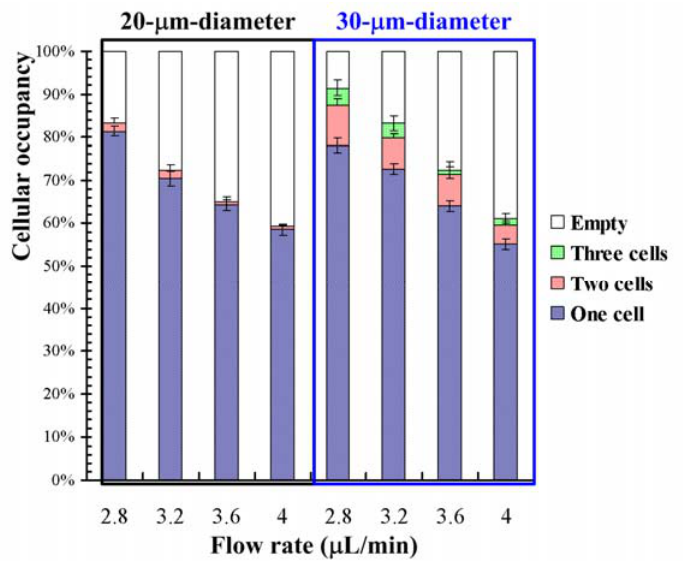
The experimental data of cell occupancy for HeLa cells in the 20- and 30- μ m-diameter microwells for various injection flow rates are plotted in Figure 3. Figure 3. Distributions of 20- μ m-diameter and 30- μ m-diameter microwell occupancies for HeLa cells for various injection flow rates. The experimental data are based on manual counts of cells in three arrays of 10 × 10 microwells. Each experimental data point represents the average value and the error bar shows the standard error from the